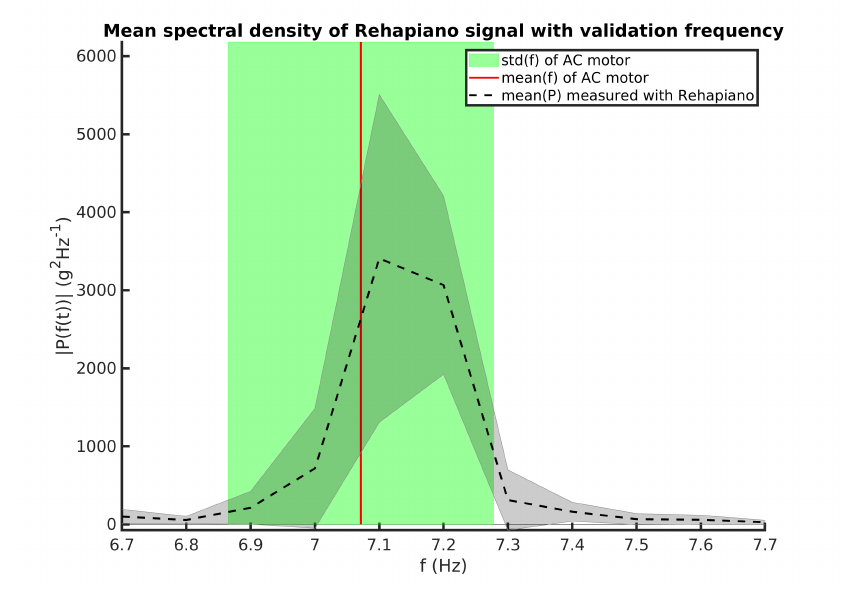
Figure 7. Mean frequency measured with optical encoder (red line), its standard deviation (green area), the Rehapiano mean power spectral density (black line), and its standard deviation (gray area) for high frequency experiments.